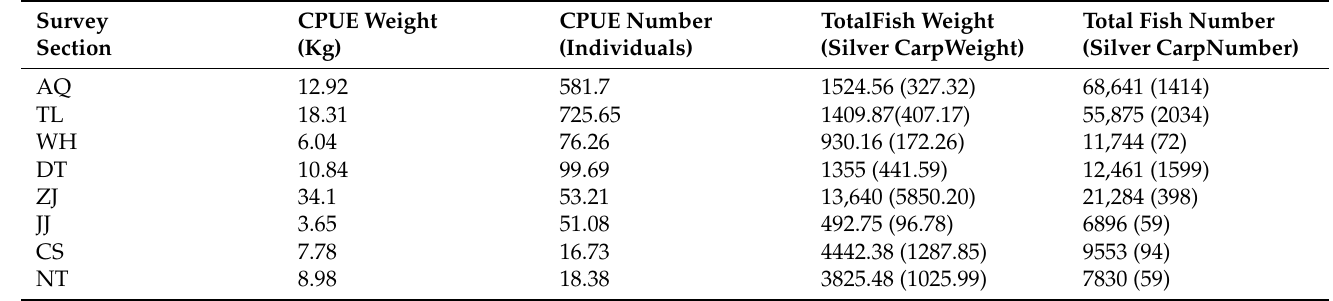
Table 2. Silver Carp sampling in each section of the lower Yangtze